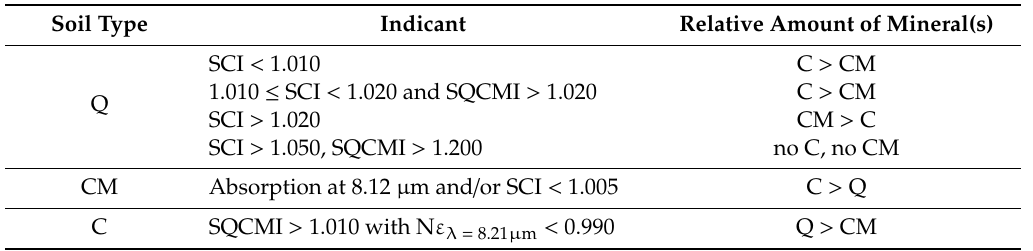
Table 3. Spectral indicants of the relative amounts of